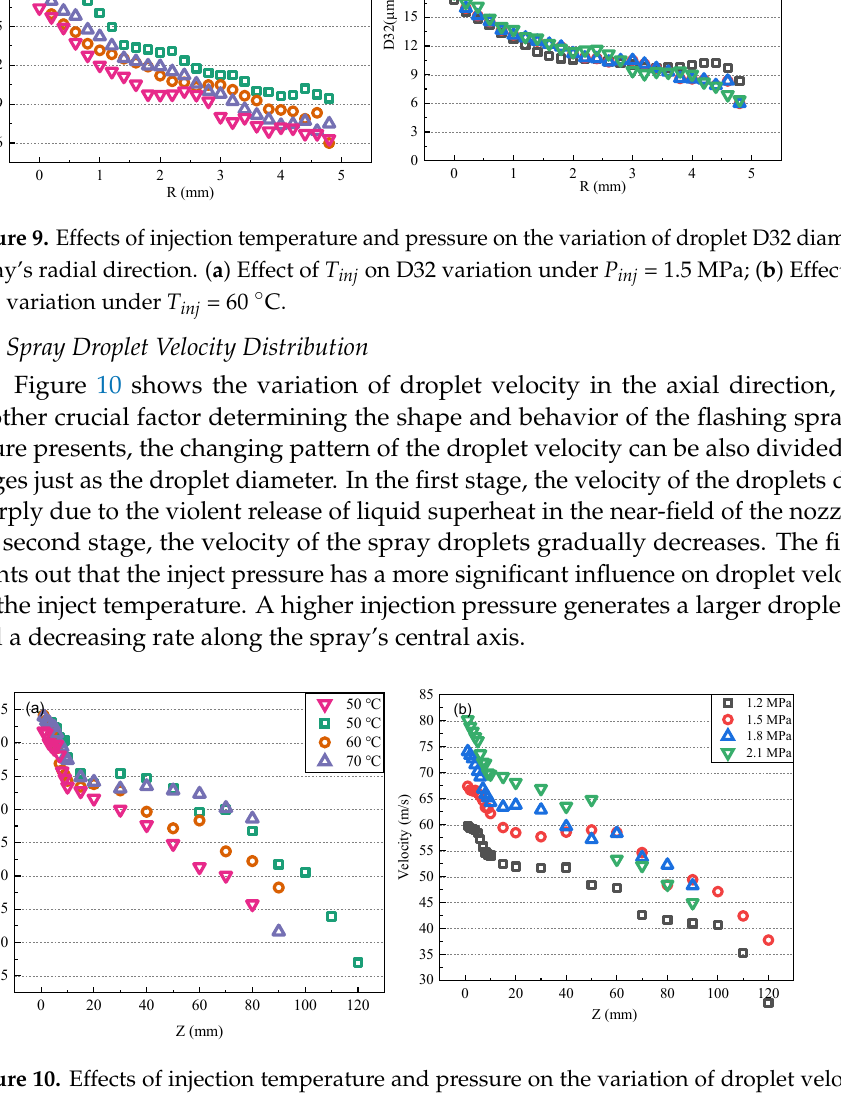
Figure 8. Effects of injection temperature and pressure on the variation of droplet D32 diameter along spray central axis. ( a ) Effect of T inj on D32 variation under P inj = 1.5 MPa; ( b ) Effect of P inj on D32 variation under T inj = 60 °C. D32 variation under T inj = 60 °C.